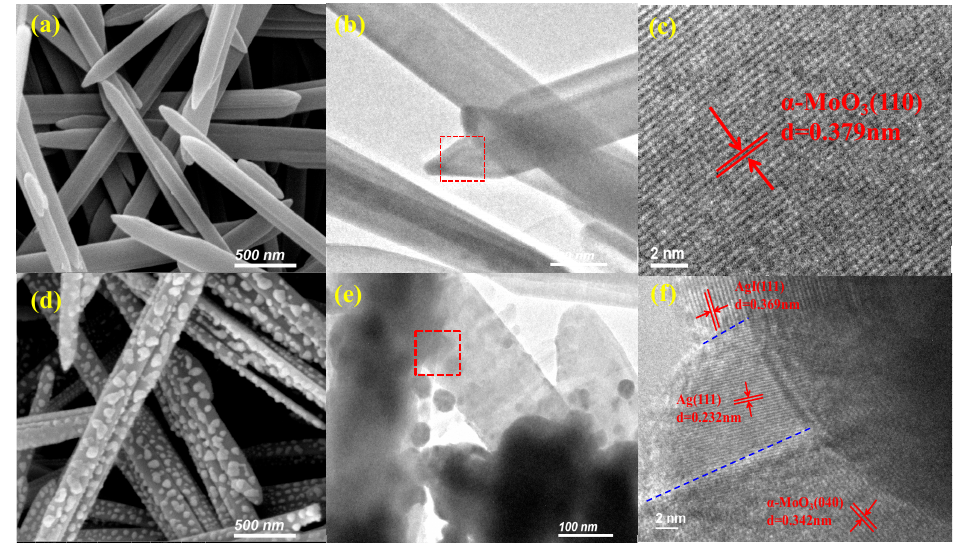
Figure 2. XPS spectra of AAM-35, ( a ) O 1s, ( b ) Mo 3d, ( c )Ag 3d, and ( d ) I 3d. The morphology and microstructure of as-made pure α -MoO 3 nanobelts and AAM-35 heterojunctions were investigated by SEM and (HR)TEM measurements, and the results are shown in Figure 3a–f. For pure α -MoO 3 , a unique belt-shaped morphology with smooth surface, sharp top and uniform belt width of about 100 nm is observed (Figure 3a). Crystalline orthorhombic α -MoO 3 nanobelts with Pbnm symmetry was confirmed by (HR)TEM images (Figure 3b,c), the lattice fringe corresponded to (110) plane of the α -MoO 3 (JCPDS No. 05-0508), and is clearly visible with a spacing of 0.379 nm. For Ag/AgI/MoO 3 heterojunction (AAM-35), Figure 3d and e clearly show that Ag/AgI nanoparticles with the size of 20–30 nm located on the surface of the α -MoO 3 nanobelts form different Ag/AgI, AgI/MoO 3 and Ag/MoO 3 heterostructures. In order to confirm the existence of metallic Ag in AAM-35, HRETM image shown in Figure 3f indicated three obviously different lattice fringes that respectively belong to the (111) plane with a spacing of 0.369 nm for AgI with F-43m symmetry, the (040) reflection plane with a spacing of 0.342 nm for α -MoO 3 , and the (111) planes with spacing of 0.232 nm for face-centered cubic metallic Ag nanoparticles with Fm-3m symmetry. These lattice fringes clearly reveal the formation of a ternary heterojunction, Ag/AgI/ α -MoO 3 , which probably further promotes the effective separation of electrons and holes between the Ag, AgI and α -MoO 3 .